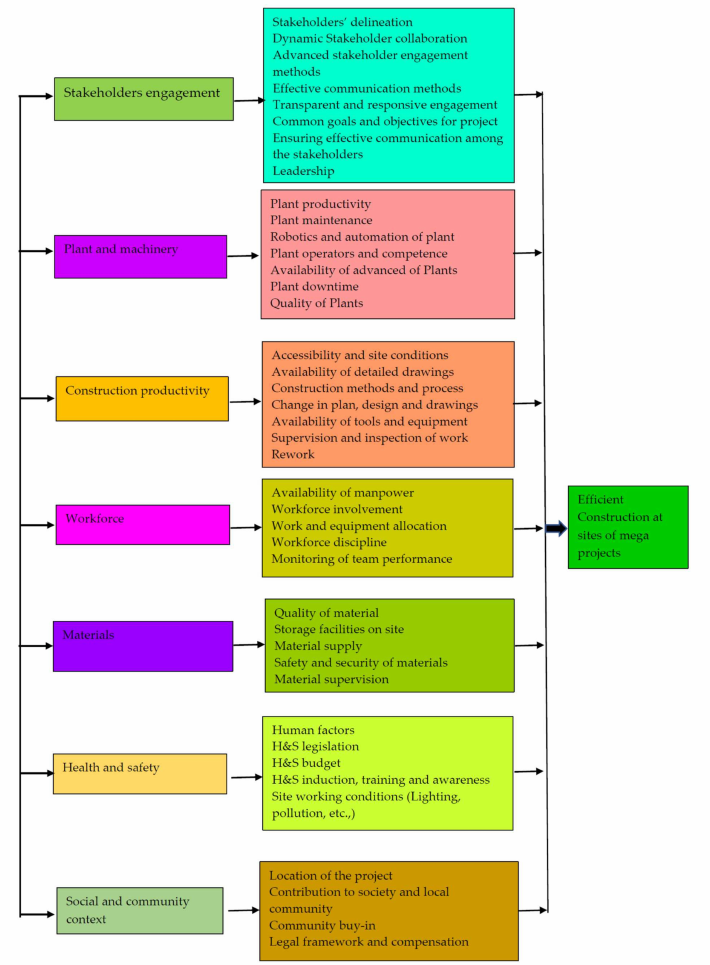
Figure 2. Conceptual framework of challenges and factors influencing the construction of mega- projects on sites. (Note: Compiled from literature sources. Please refer to Table A1 in Appendix